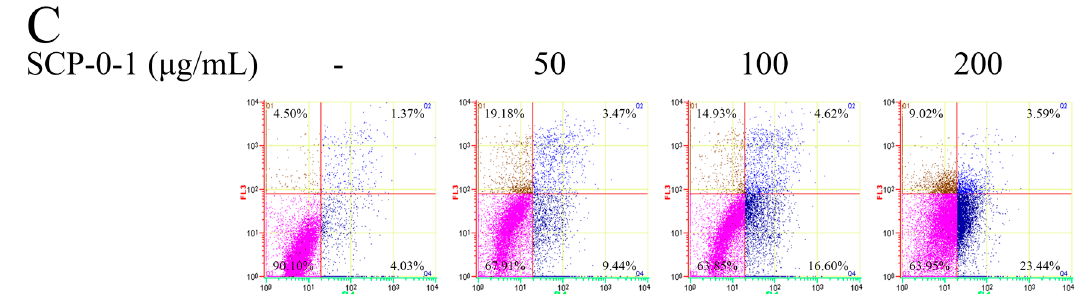
Figure 2. The effectiveness of S. Chinensis polysaccharide-0-1 (SCP-0-1) on cell viability and apoptosis in human hepatocellular liver carcinoma (HepG2) cells. ( A ) The cells were incubated with SCP-0-1 (0–200 µg/mL) for 24 h as determined via adopting the 3-[4,5-dimethyl-2-thiazolyl]-2,5-diphenyltetrazolium bromide (MTT) assay. Its related data were presented as the mean values ± SD of three independent experiments. * p < 0.05 and *** p < 0.001 versus control group; ( B ) Effect of SCP-0-1 on the cell-cycle and sub zero gap/first gap (subG0/G1) apoptotic population of the HepG2 cells. The HepG2 cells were treated with SCP-0-1 (0–200 µg/mL) and fixed for 24 h for flow cytometry (FCM). The deoxyribonucleic acid (DNA) content of propidium iodide-labelled nuclei was analysed. The populations of subG0/G1 apoptosis and of zero gap/first gap (G0/G1), synthesis (S), and second gap/mitosis (G2/M) phase were quantified by using DNA histograms; ( C ) Cell death of cells assessed using flow cytometry. Cell apoptosis detection with flow cytometry are proceeded by adopting the Annexin-V/phosphatidylinositol (PI) Apoptosis Detection Kit. 2.3. Cell Morphology Demonstrated that S. chinensis Polysaccharide-0-1 Induced Apoptosis